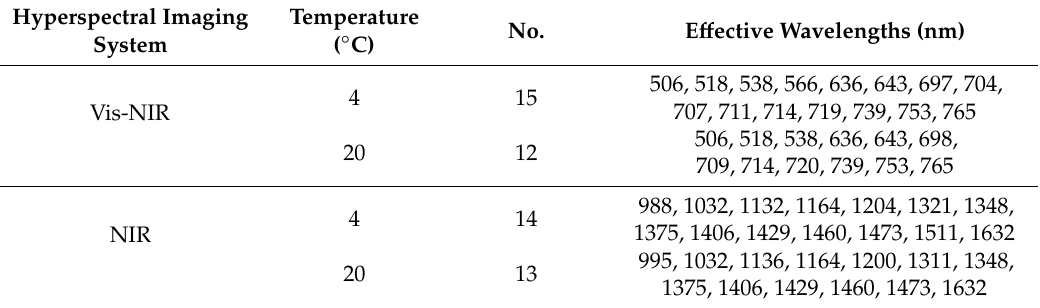
Table 1. Corresponding e ff ective wavelengths selected by second-order derivative spectra.